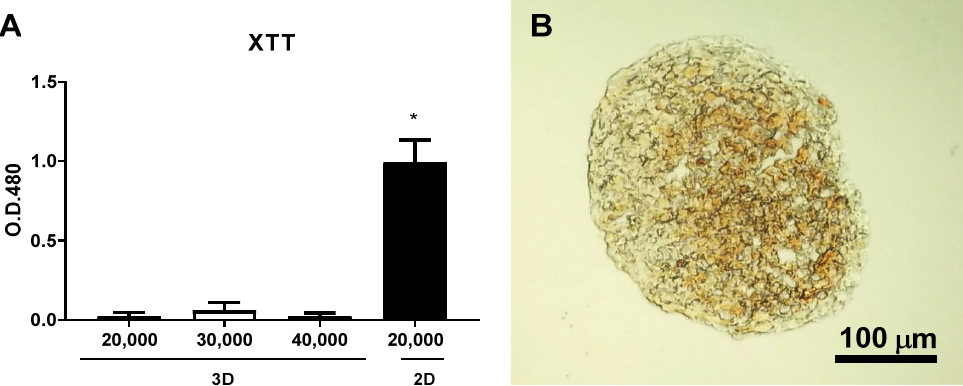
Figure 6. ( A ) Optical density of the XTT assay, with different cell densities incubated for 4 h. Bars represent the mean ± SD (n = 5) optical density at 480 nm. The black bar indicates the result obtained with monolaminar cell culture of MC3T3 ‐ E1 cells form the same origin as those used in the aggregates. ( B ) 7 μ m section of spheroid with 20,000 cells after incubation with XTT. An asterisk indicates significative difference from other groups ( p < 0.05). All experiments were performed with spheroids at the 4th day after formation.